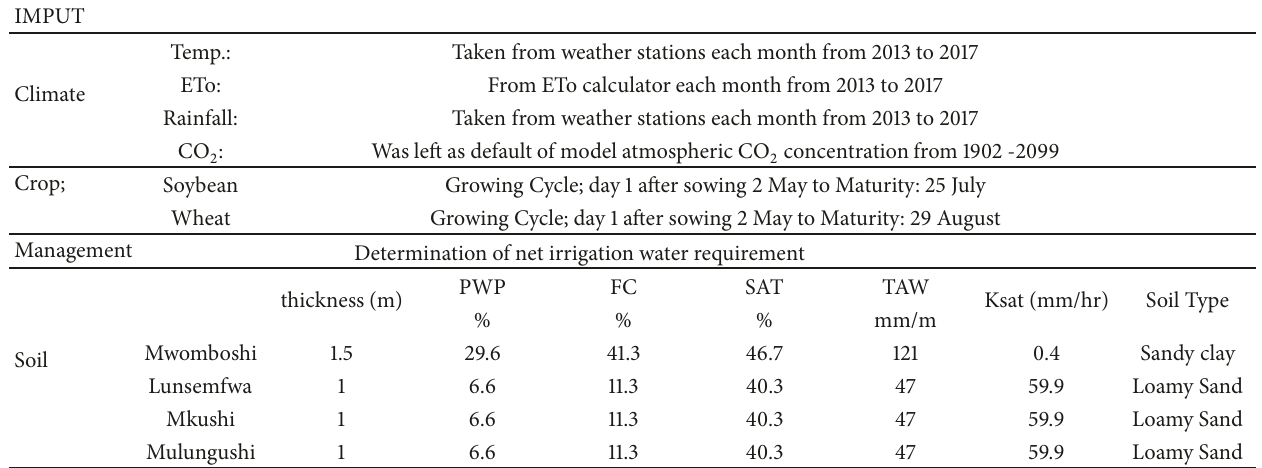
Table 1: Information used to run the AquaCrop